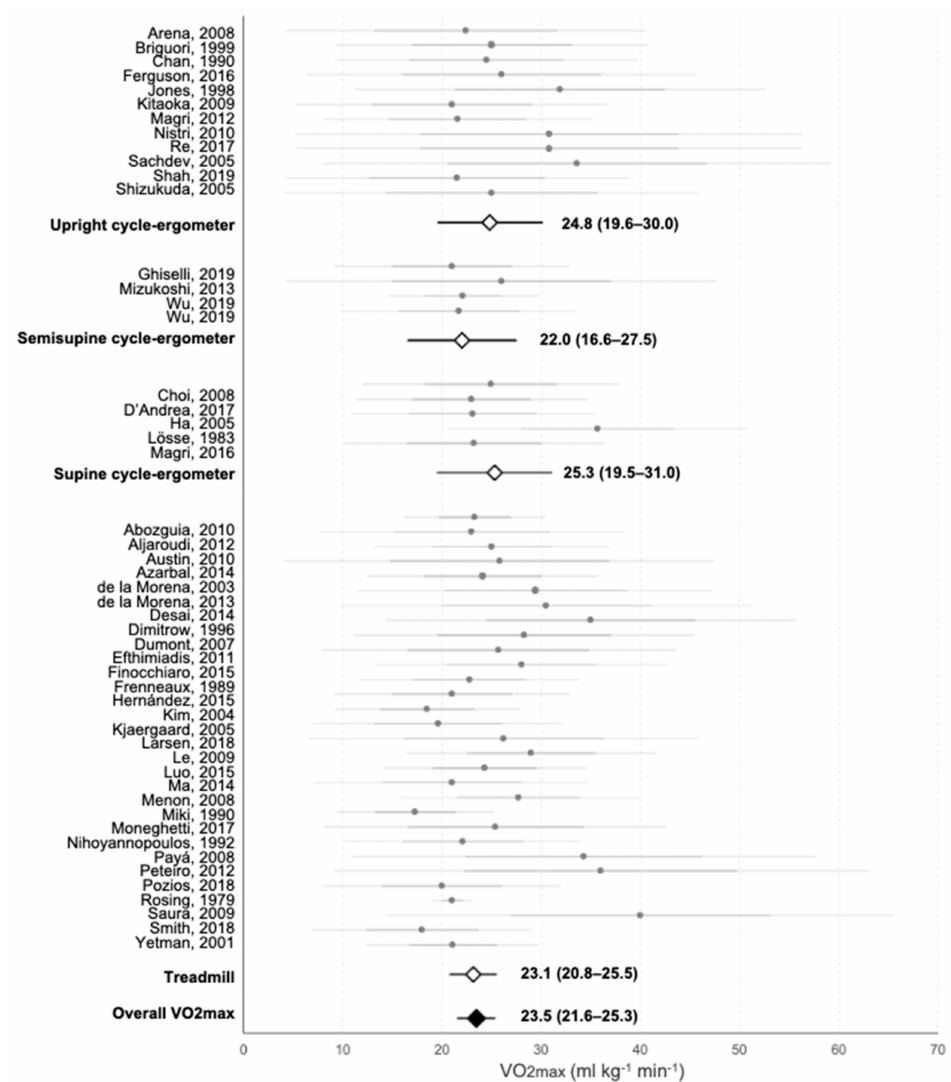
Figure 2. Meta-analysis of the VO2max reported on each study and average values for each ergometer used on the assessment of functional capacity. Grey points represent the average value of each individual study. Darker horizontal lines intersecting them represent the upper and lower value of the mean ± SD, and lighter horizontal lines show 95% CI. White rhombi intersected by a black line represent the mean VO2max and 95% CI of each ergometer as extracted from the meta-analysis. The black rhombus represents the mean value and 95% CI of all studies as extracted from the meta-analysis. Numerical values of each subgroup and the whole group are